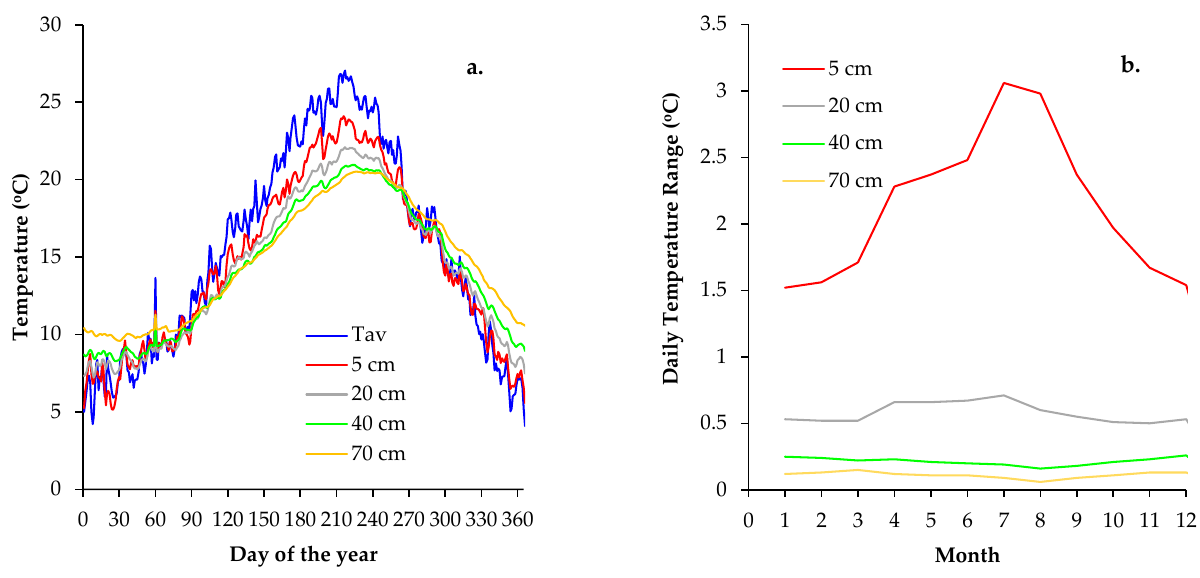
Figure 7. Average ( a ) daily values of soil and air temperatures T av and ( b ) monthly diurnal temperature range, at the four depths for an annual period.